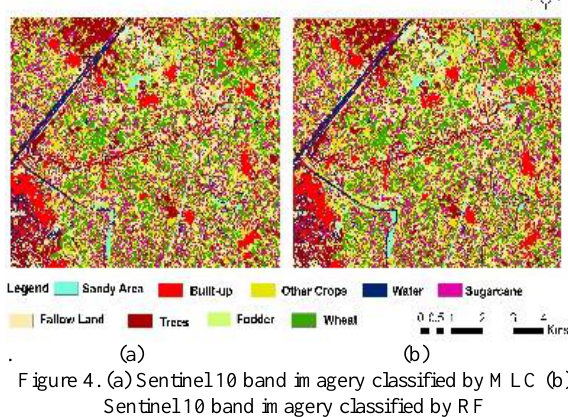
Figure 3. (a) Sentinel 4-band imagery classified by MLC (b) Sentinel 4 band Imagery classified by RF.